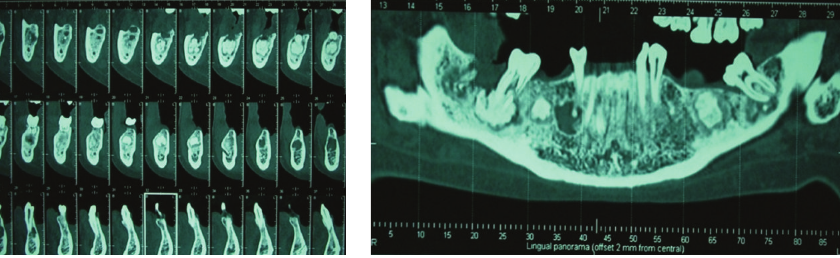
Figure 2: TC dental scan of the mandible.